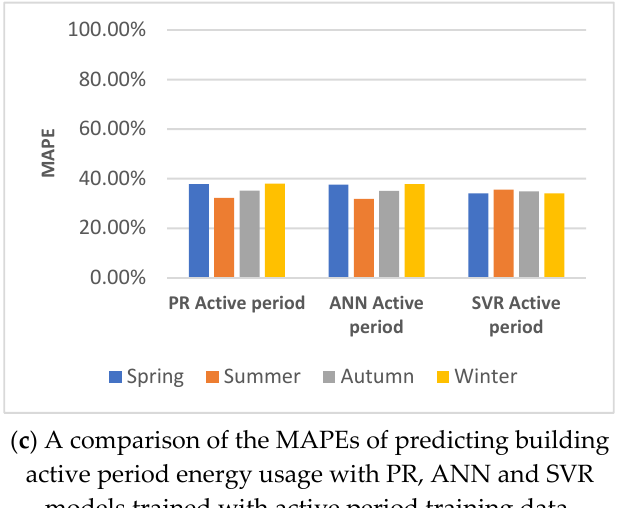
( b ) A comparison of the MAPEs of predicting building dormancy period energy usage with PR, ANN and SVR models trained with unsegmented training data.